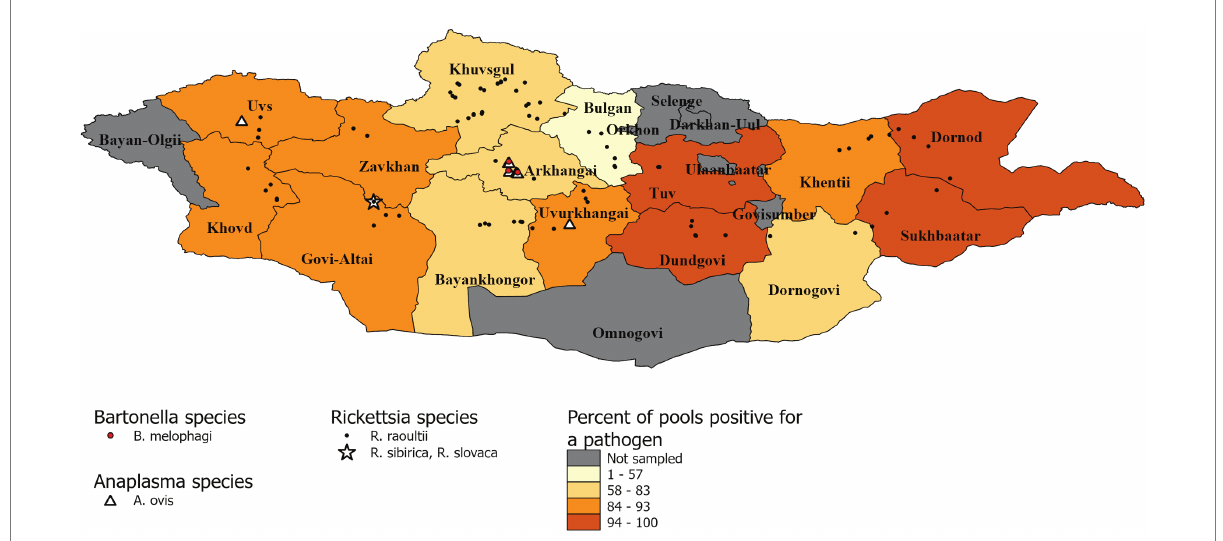
FIGURE 6 Distribution of identified microbial species and pool positivity rate by aimag. A map demonstrating the geographic distribution of microbial species identified within the sampled tick pools. Each identified microbial species has a different symbol. The aimags are colored according to the proportion of pools that tested positive for Anaplasma, Bartonella, or Rickettsia